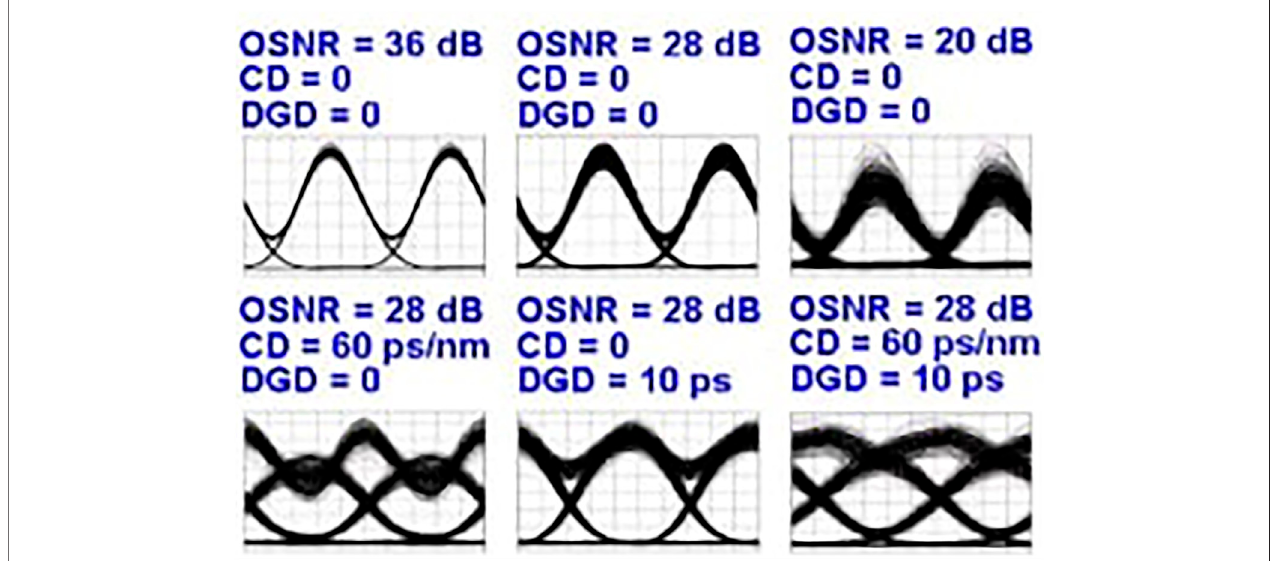
FIGURE 4 | Impact of various impairments on the eye diagram of an RZ signal (Wu et al., 2009).